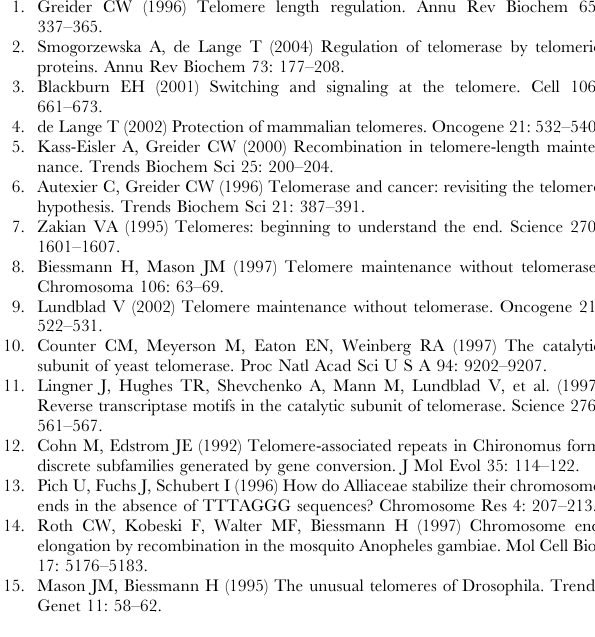
Figure S1 Life span analysis of type II survivors with different genetic background. (A) Life span curves of est2 D type II survivors